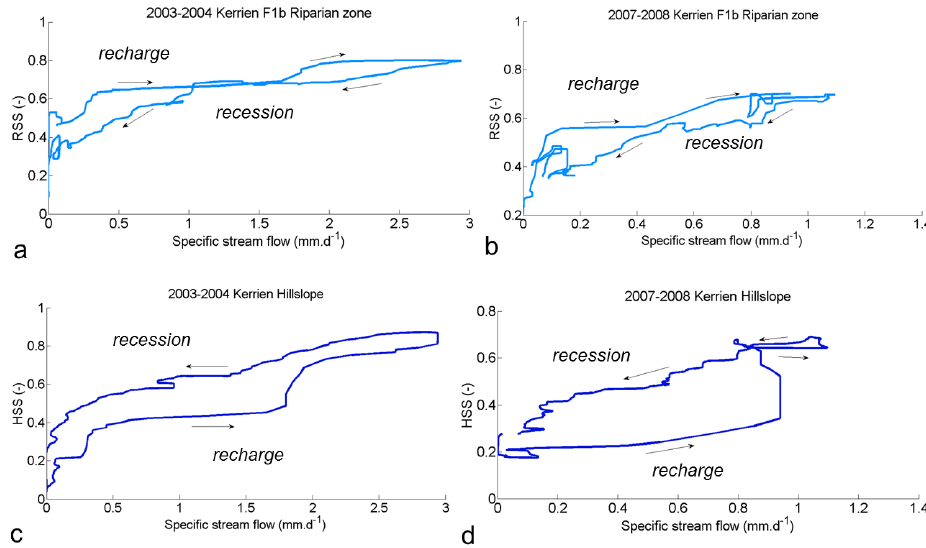
Figure 4. Examples of annual hysteretic loops for saturated-zone storage vs. stream flow which are clockwise in the riparian zone (a, b) and anticlockwise in the hillslope (c, d) for the wet year 2003–2004 (a, c) and the dry year 2007–2008 (b, d) .